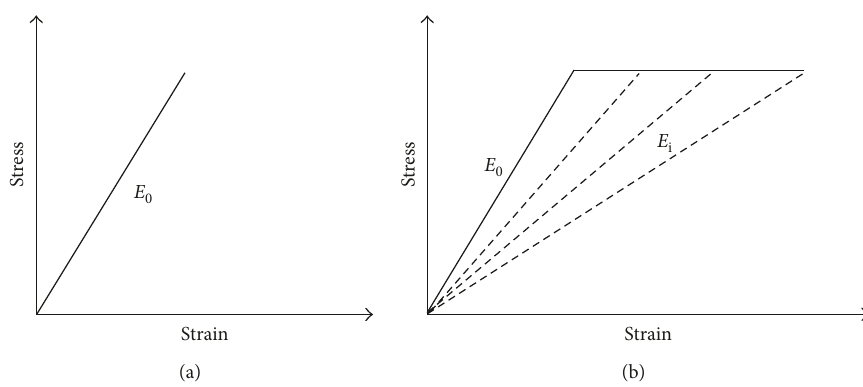
Figure 5: Mechanical properties of (a) matrix beam and fiber beam and (b) interface beam.